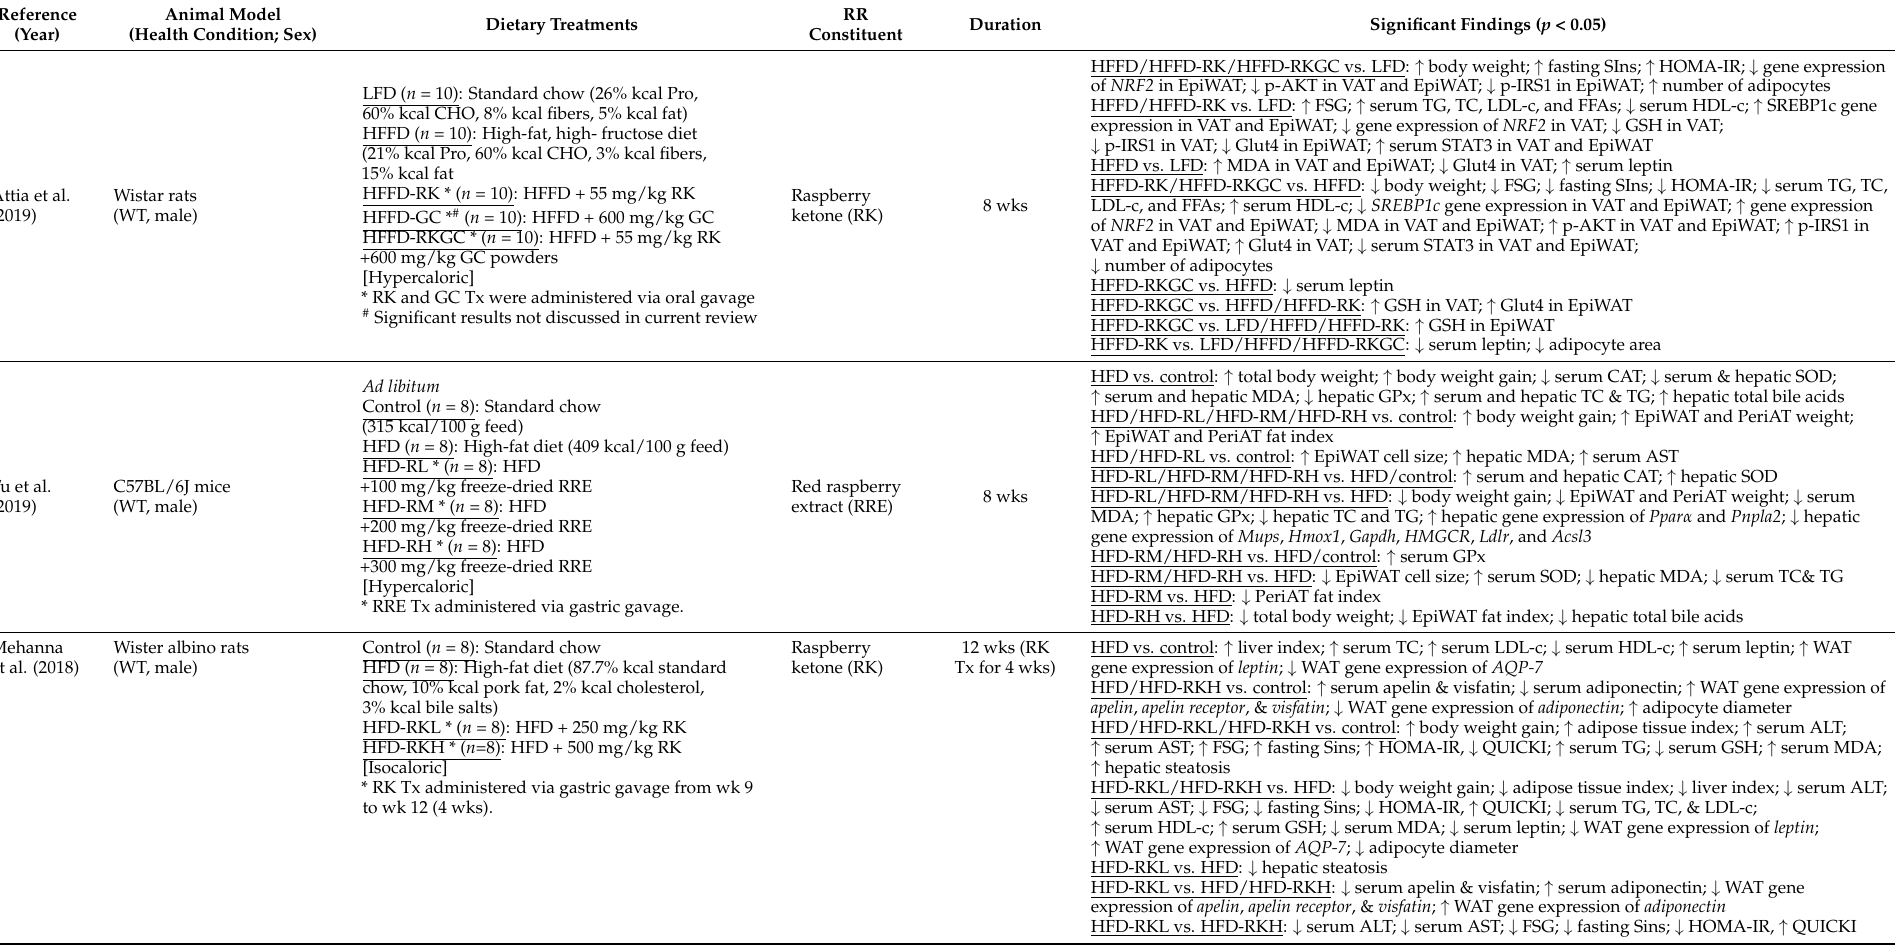
Table 3. Summary of animal studies investigating the effects of extracts or functional constituents of red raspberries on metabolic